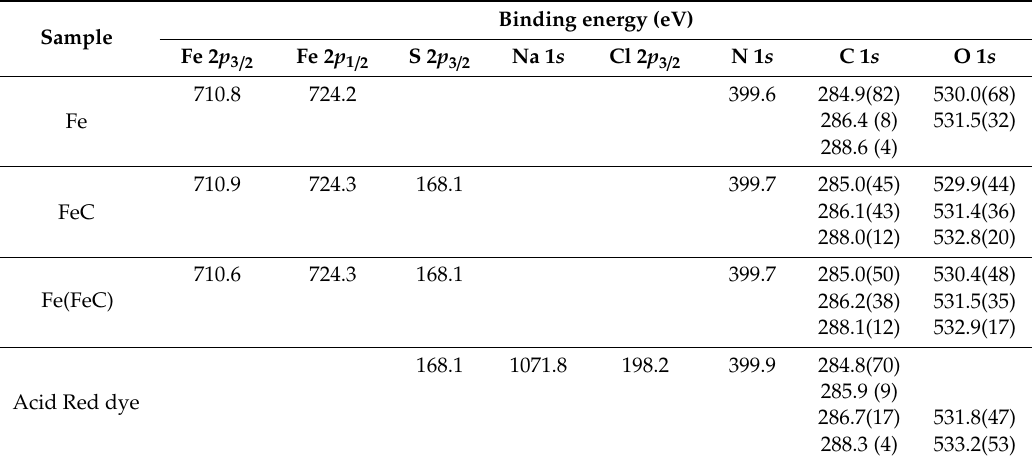
Table 8. XPS data obtained from the spectra of the